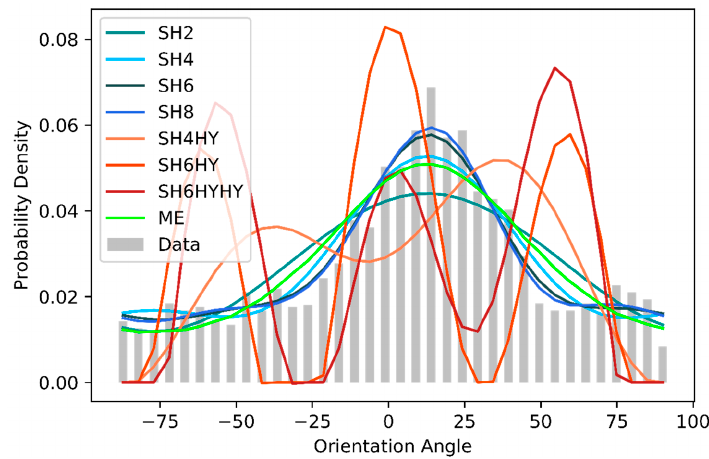
Figure 12. Measured and reconstructed ODFs from [7].